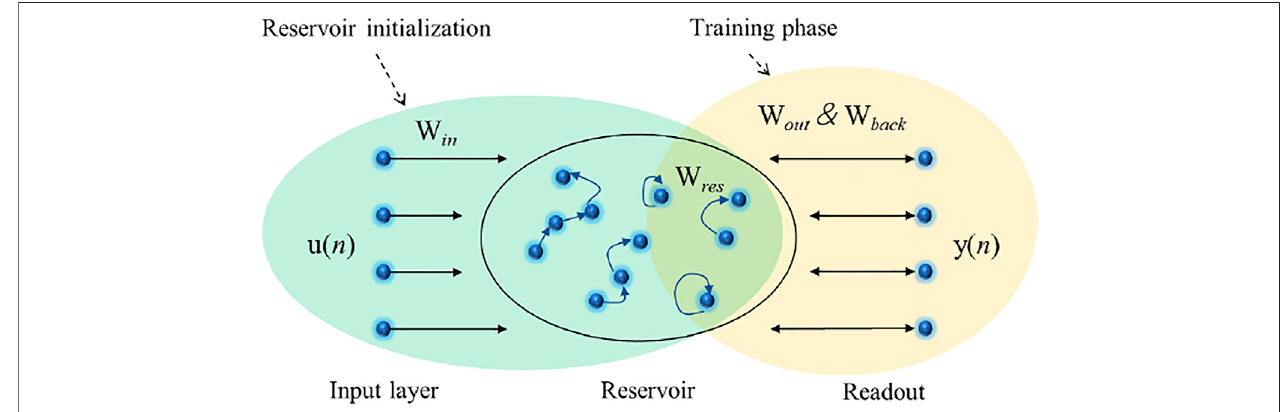
FIGURE 2 | Architecture of the echo state